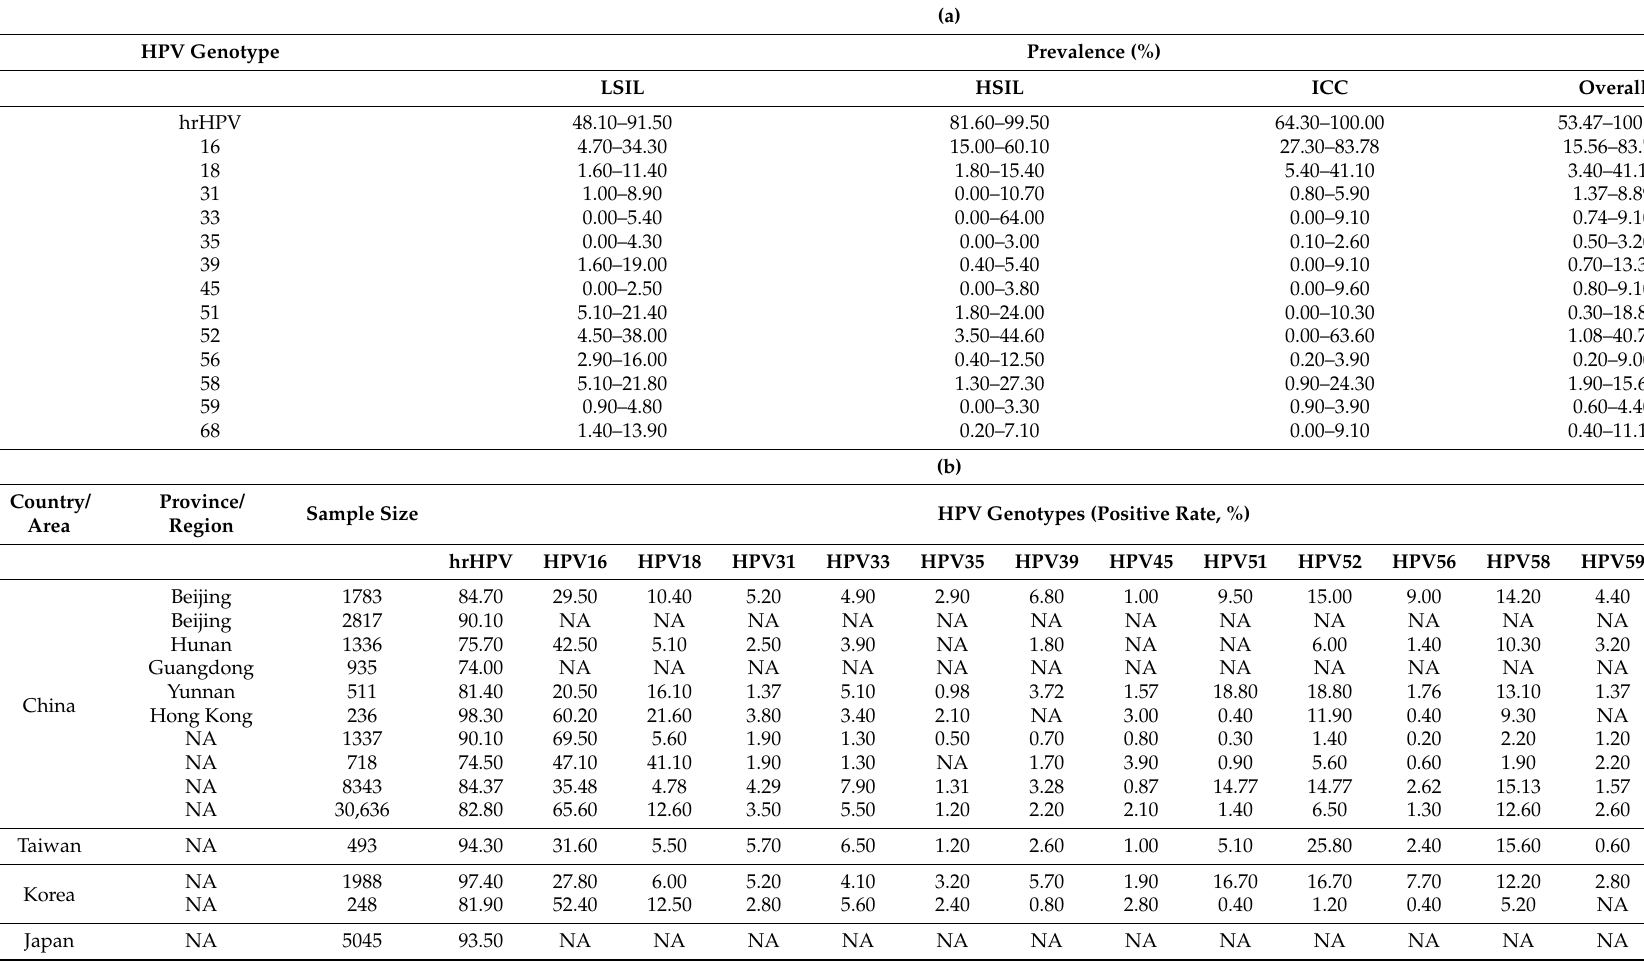
Table 1. Distribution of HPV genotypes in cervical cancer patients in East, Southeast, and South Asia. ( a ) A summary of HPV genotypes detected in different cervical lesions. ( b ) The prevalence of HPV genotypes in cervical patients by countries and